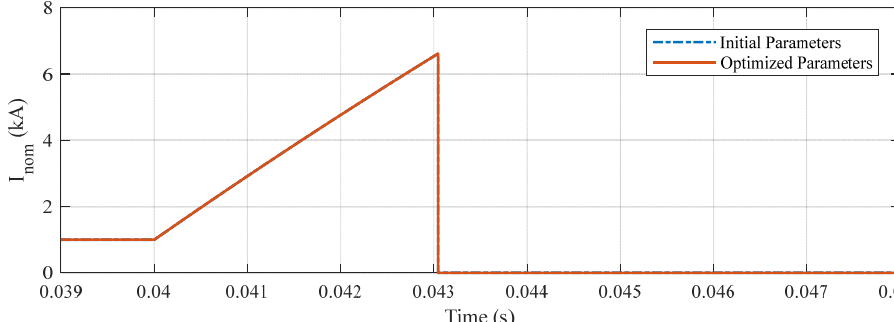
Figure 7. Current waveform of I (cid:2924)(cid:2925)(cid:2923) in branch 1 of the HCB